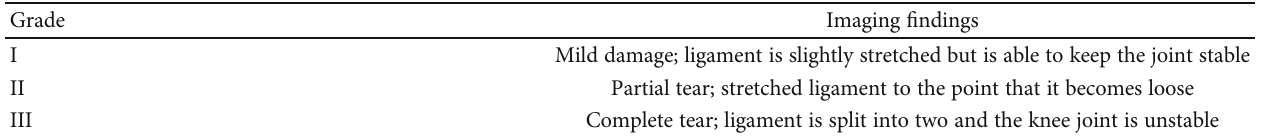
Table 2: Grading of anterior cruciate ligament